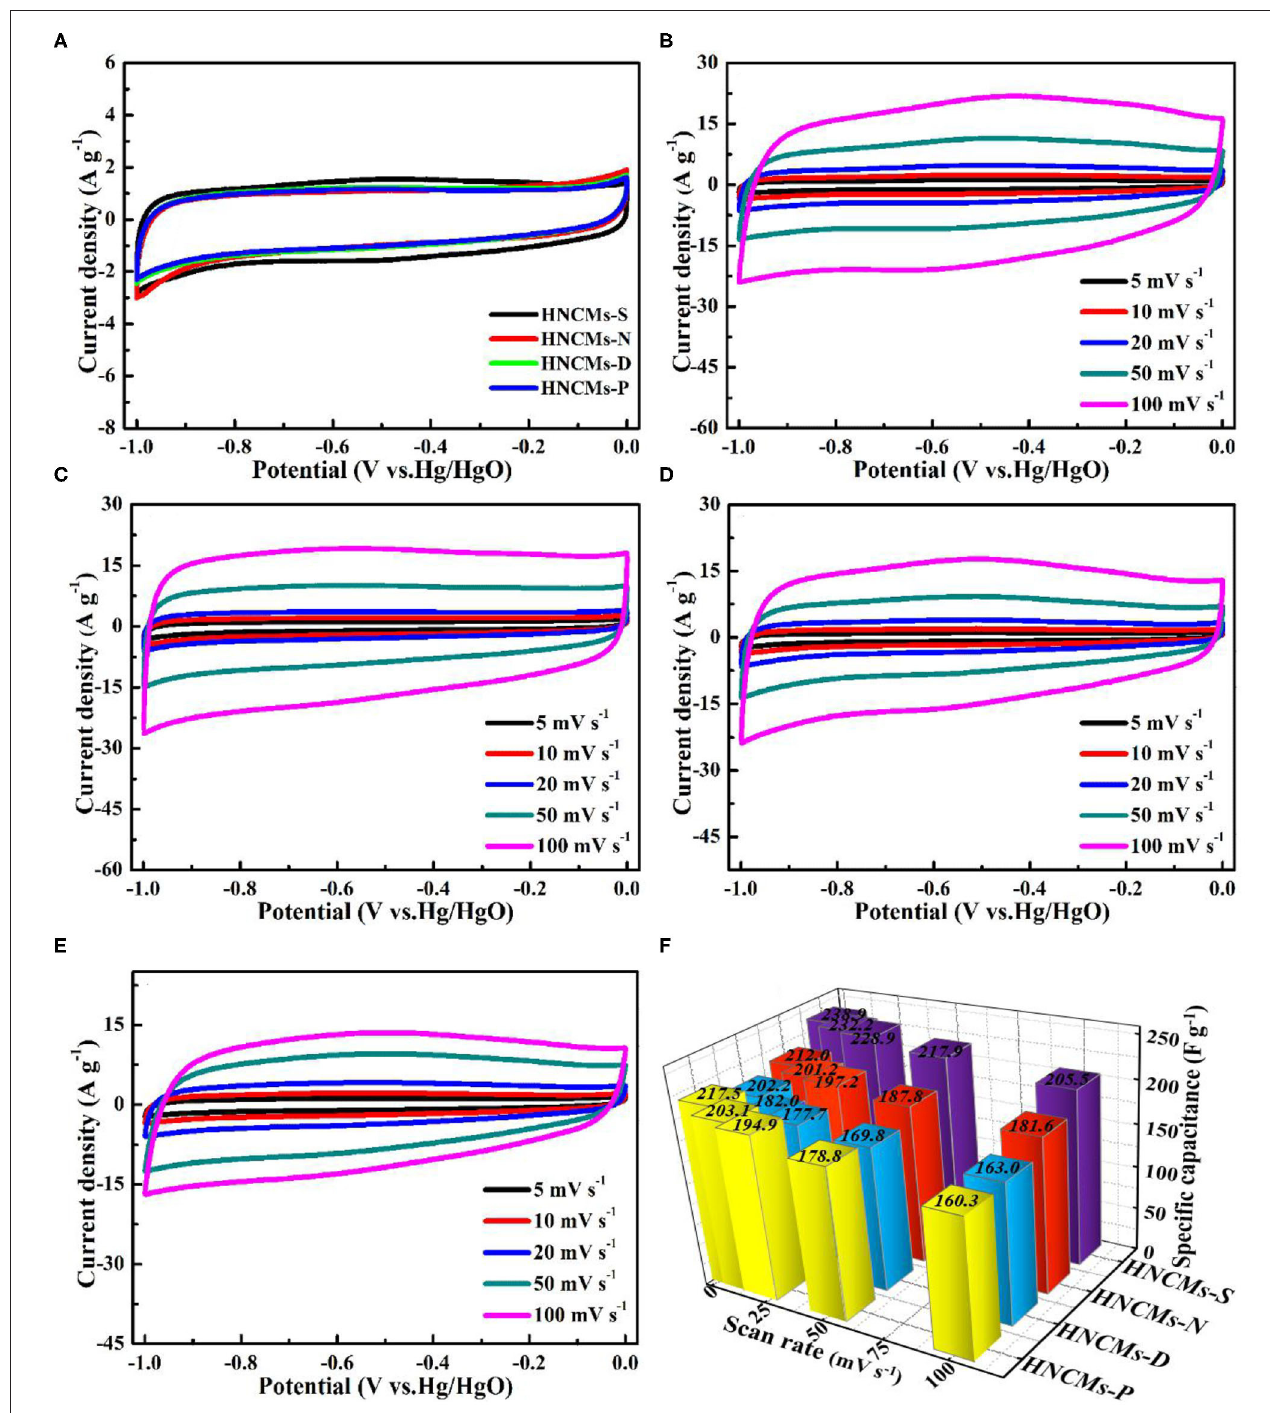
FIGURE 4 | (A) CV curves of HNCM electrodes at a scan rate of 5mV s − 1 , CV curves of HNCM electrodes at different scan rates: (B) HNCMs-S, (C) HNCMs-N, (D) HNCMs-D, and (E) HNCMs-P. (F) Specific capacitance of the HNCM electrodes as working electrodes at different scan rates.